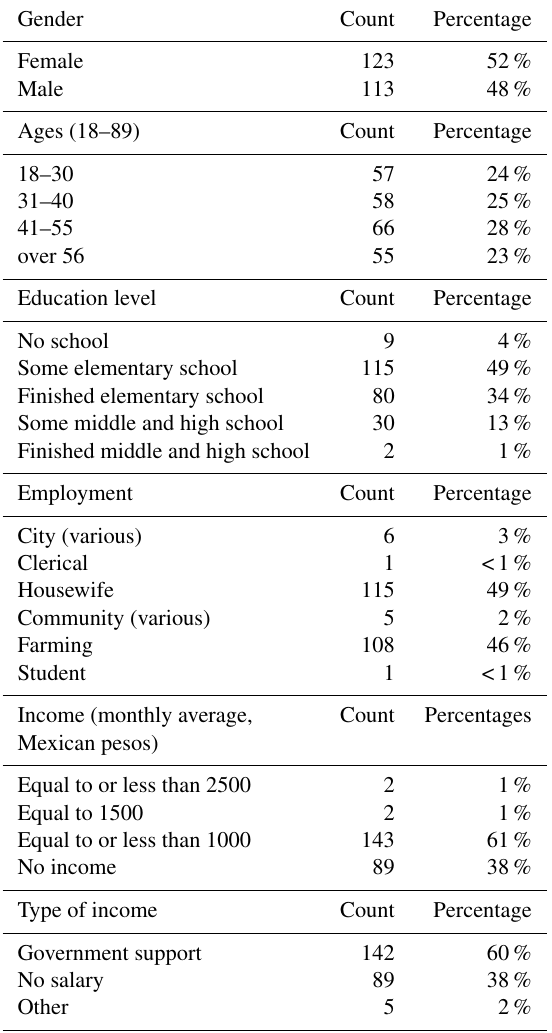
Table 1. Demographic information for all